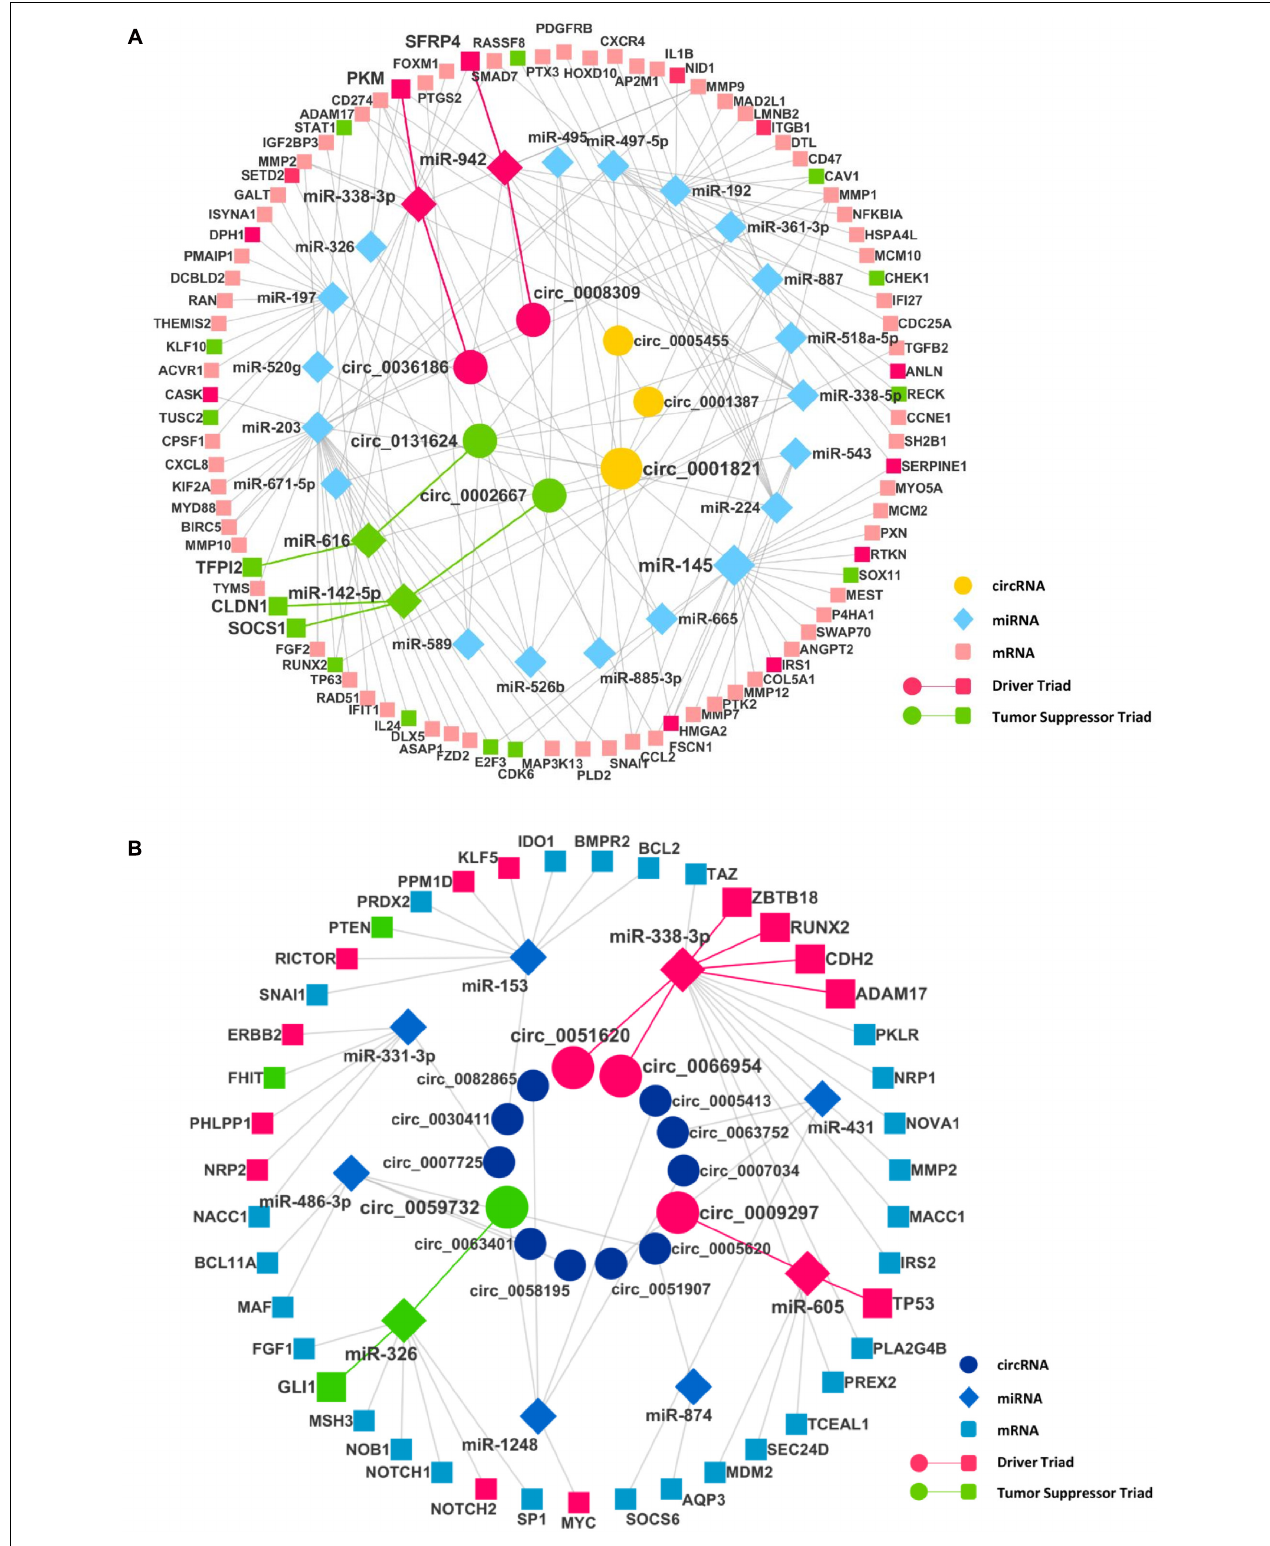
FIGURE 2 | The circRNA–miRNA–mRNA regulatory networks in (A) head and neck squamous cell carcinoma (HNSCC) and (B) lung cancer. Nodes (inner to outer) represent differentially expressed circRNAs, miRNAs, and mRNAs, respectively. The circular nodes represent circRNA, diamonds represent miRNAs, and square nodes represent the mRNAs. The red and the green highlighted circRNA–miRNA–mRNA interaction represent a driver and tumor suppressor triads, respectively.